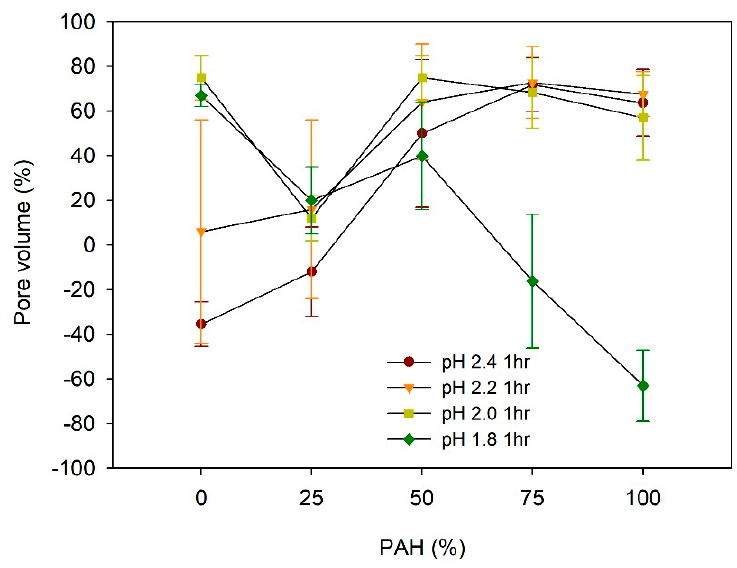
Figure 5. Pore volume of LbL films as a function of PAH ratio and acid treatment.